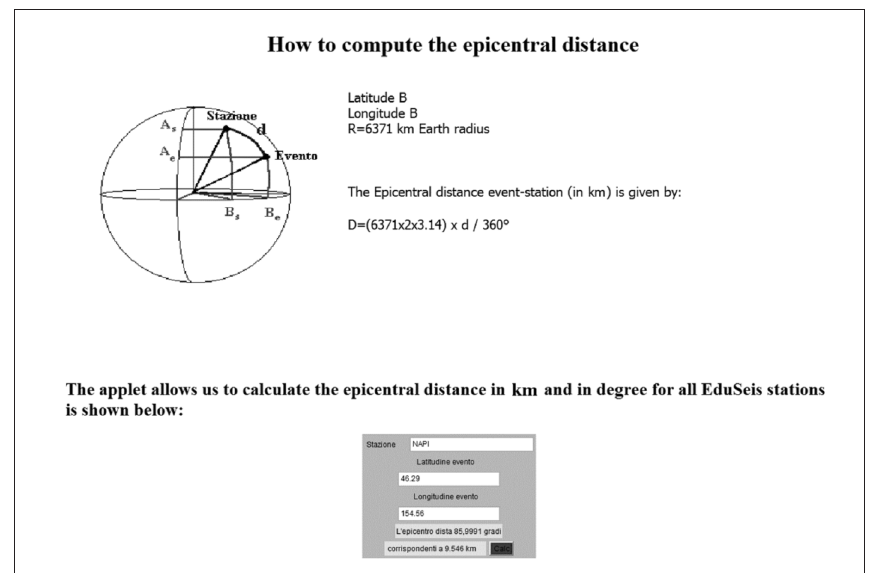
Fig. 4. A web tool for a didactic